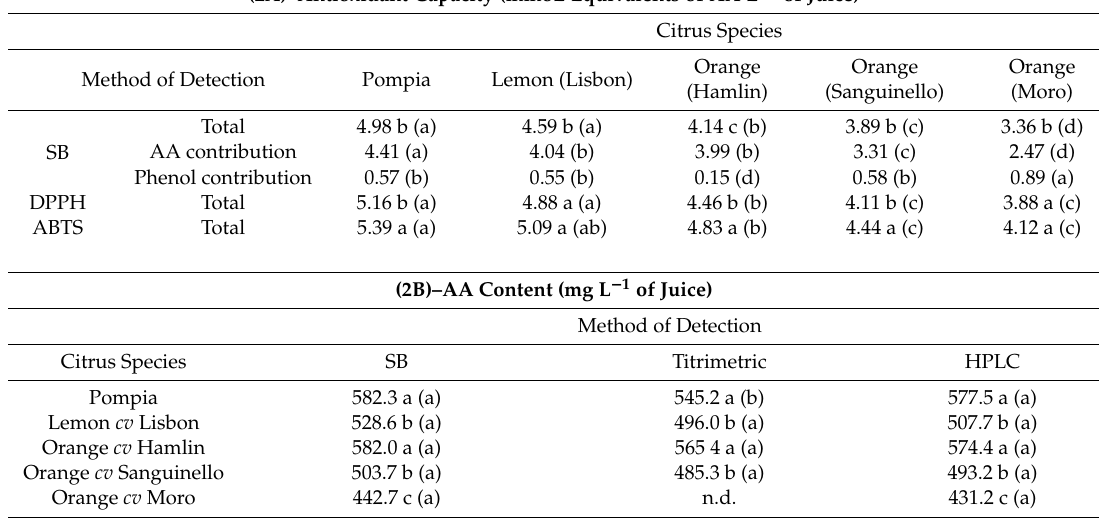
Table 2. (2A) Antioxidant capacity (ascorbic acid equivalents) as determined by SB electrochemical system at + 500 mV, by DPPH (EPR) and by ABTS (spectrophotometric) reference methods, in the juices of Pompia, lemon ( cv Lisbon), and oranges ( cv Hamlin, Sanguinello, and Moro). AA and phenolics contributions to antioxidant activity were also provided by SB system. (2B) Ascorbic acid content (mg L − 1 ) as determined by SB system at + 500 mV, titrimetric, and HPLC methods in the juices of Pompia, lemon ( cv Lisbon), and oranges ( cv Hamlin, Sanguinello and